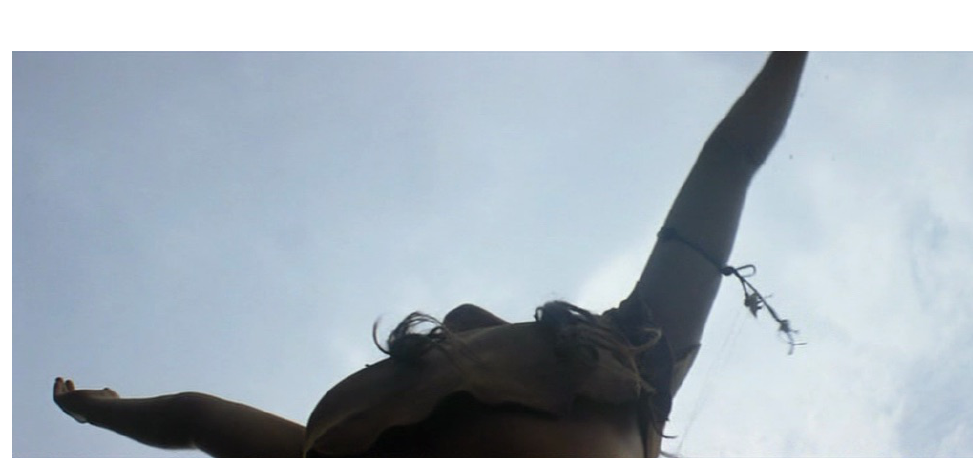
Figure 2: Pocahontas’ salutation is sky- rather than sun-directed.